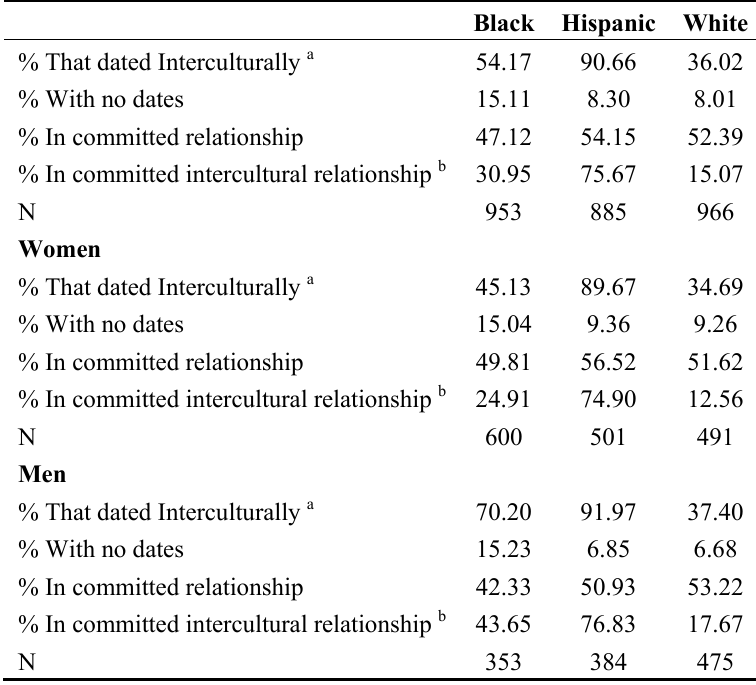
Table 1. Group differences in romantic relationship experiences. Black Hispanic